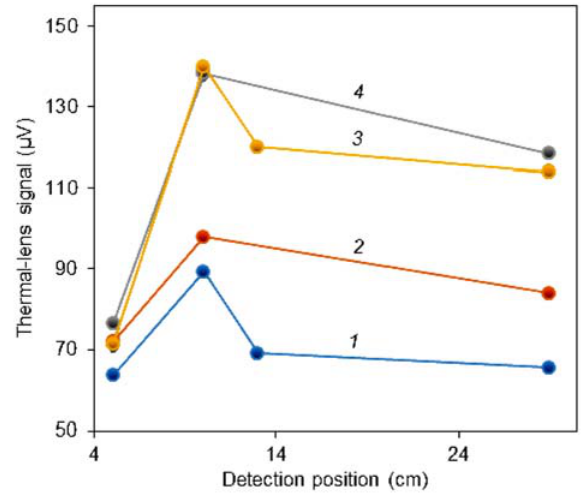
Figure 4. Dependence of the thermal-lens signal of Cr(VI) (4 μmol L –1 ) complex with diphenylcarbazide (20 μmol L –1 ) for various flow rates and injection volumes of the reagent (1) V = 0.6 μL and q = 10 μL min –1 ; (2) V = 0.6 μL and q = 5 μL min –1 ; (3) V = 0.9 μL and q = 10 μL min –1 ; (4) V = 0.9 μL and q = 5 μL min –1 ; excitation power, 100